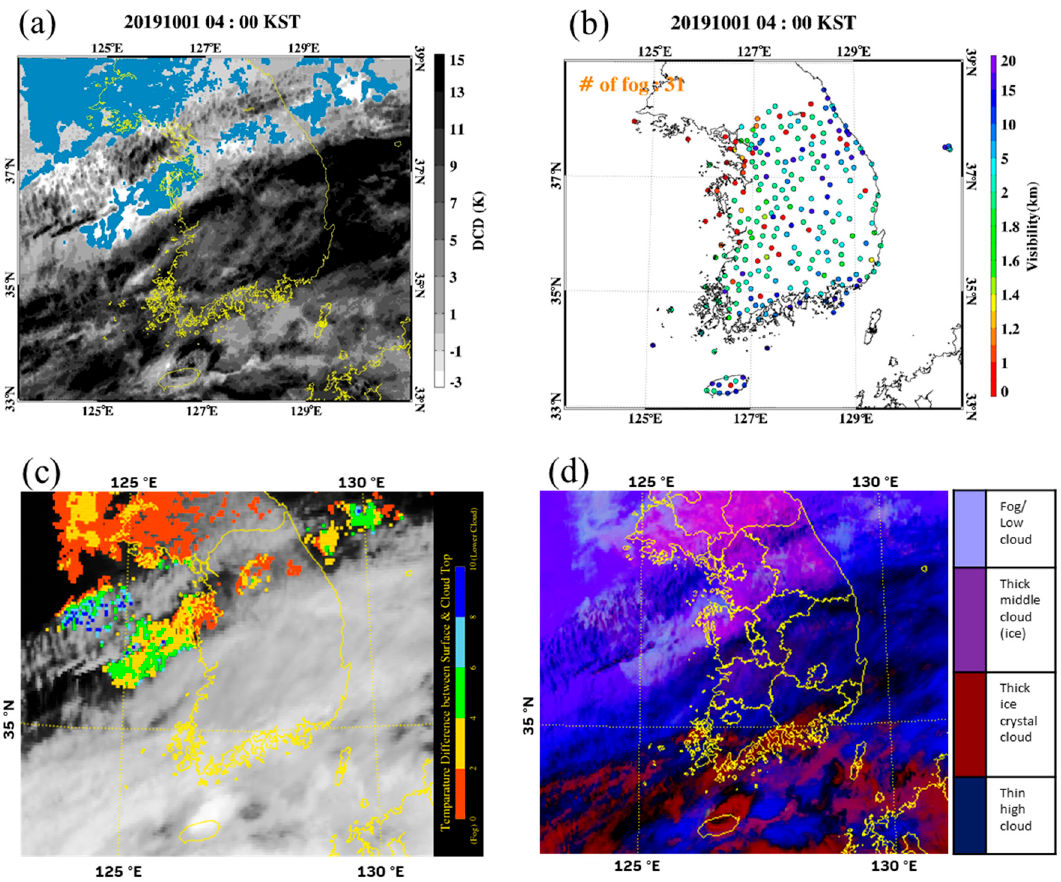
Figure 10. Sample image of fog detection results at 04:00 KST on 01 October 2019. ( a ) Fog image of GK2A_FDA, ( b ) ground-observed visibility, ( c ) fog image of CMDPS, and ( d ) fog product of GK2A RGB. Sky blue color in ( a ) indicates foggy pixels.